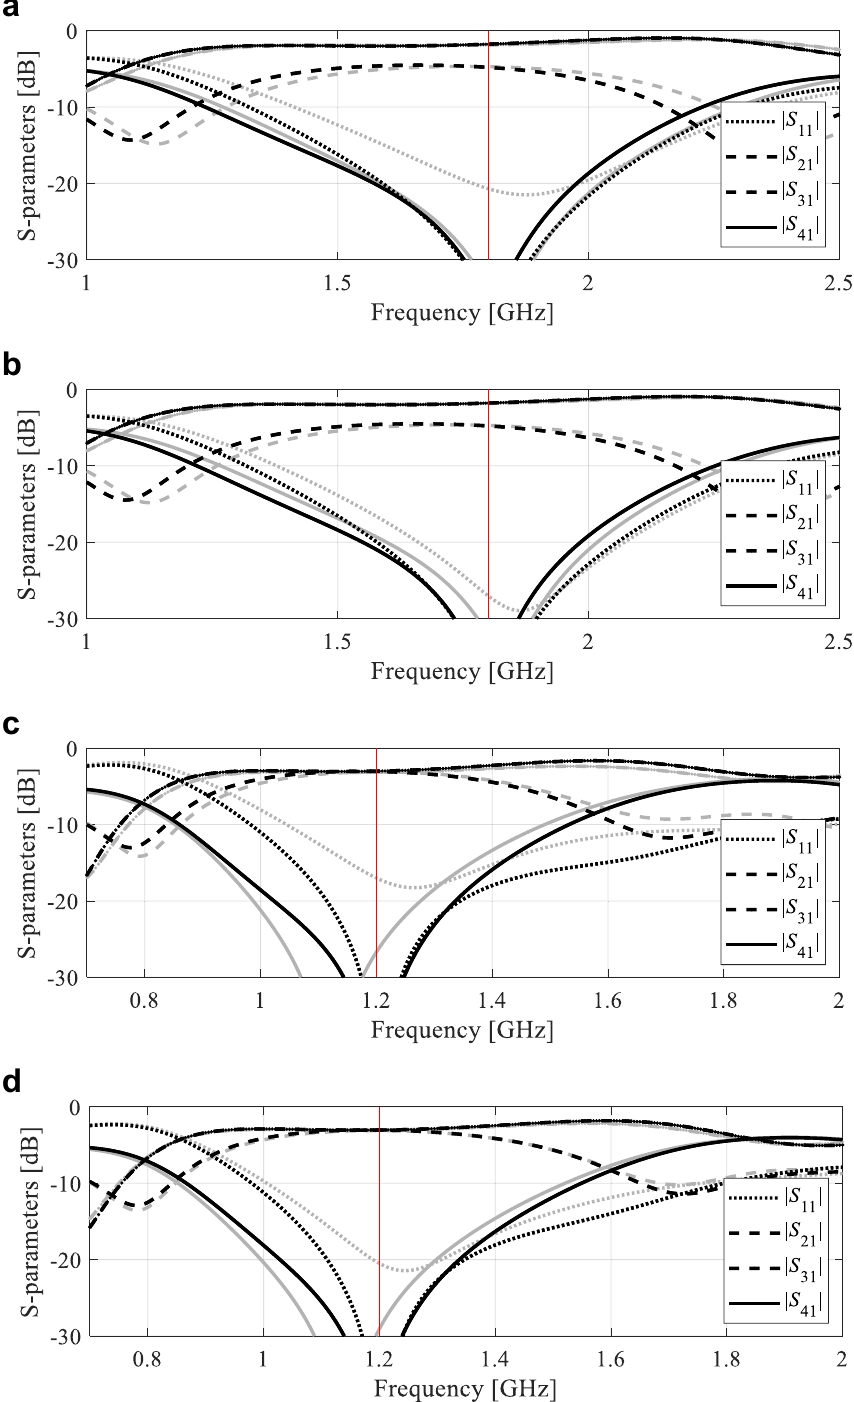
Figure 7. Circuit I: S-parameter characteristics at the optimized designs found by the proposed global optimization framework for two selected algorithm runs, Case 1: ( a , b ) Designs 1 and 2, respectively, Case 2: ( c , d ) Designs 1 and 2, respectively. Gray lines correspond to the initial design x (0) obtained using the global search stage, black lines represent the responses at the final design. Vertical lines mark the target operating